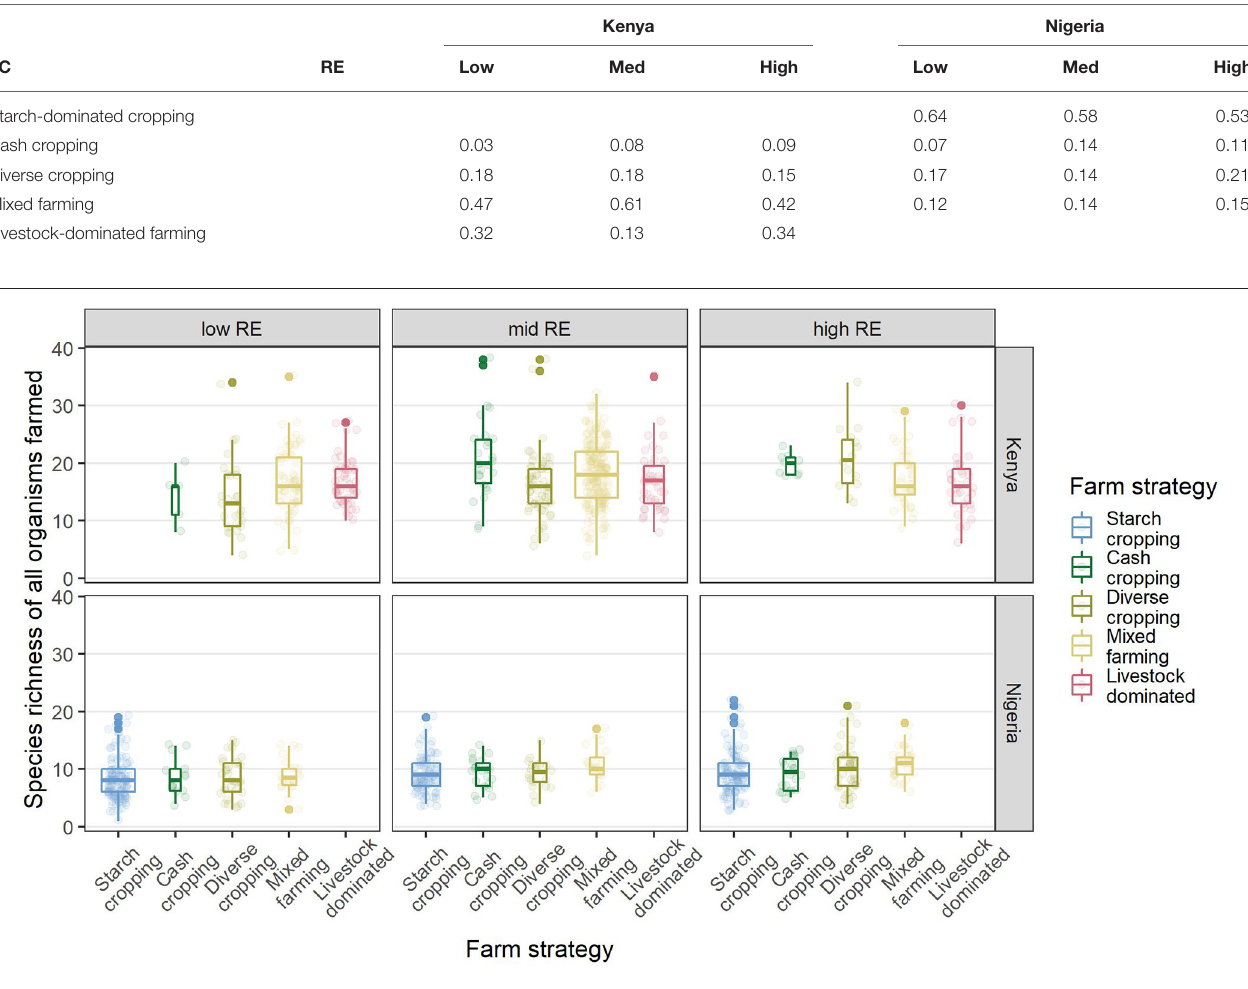
FIGURE 6 | Total farm species richness in different FC (x axis) and RE (panel columns) groups in Kenya and Nigeria (panel rows). Solid lines indicate medians, boxes indicate interquartile ranges, whiskers indicate points up to 1.5 × the interquartile range while dots indicate outliers beyond that. Pale dots show the raw data (each point represents a